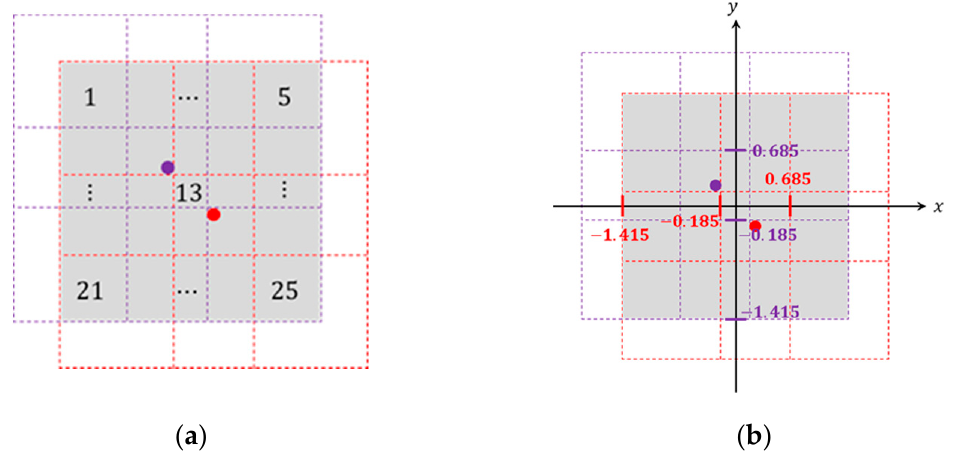
Figure 4. ( a ) The detection area of the proposed system, where the red (resp. purple) point is Rec (resp. Trans1) and ( b ) the two-dimensional coordination of Rec (resp. Trans1) is (0.25, − 0.25) (resp. ( − 0.25, 0.25)).